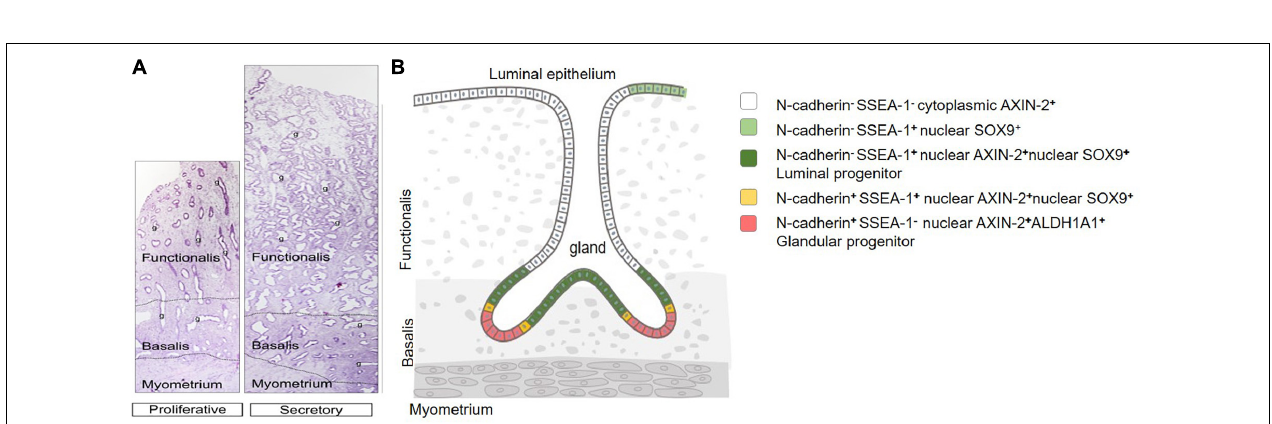
FIGURE 1 | Scanning electron microscopy of human endometrial microarchitecture during menstruation. (A) Day 2, basalis glandular epithelial stump protrudes into the uterine lumen. (B) Day 4, newly formed luminal epithelium progressively covering fibrin-coated denuded areas. (C) Day 7, re-epithelialization has been completed. Adapted with permission from Ludwig and Spornitz (1991).